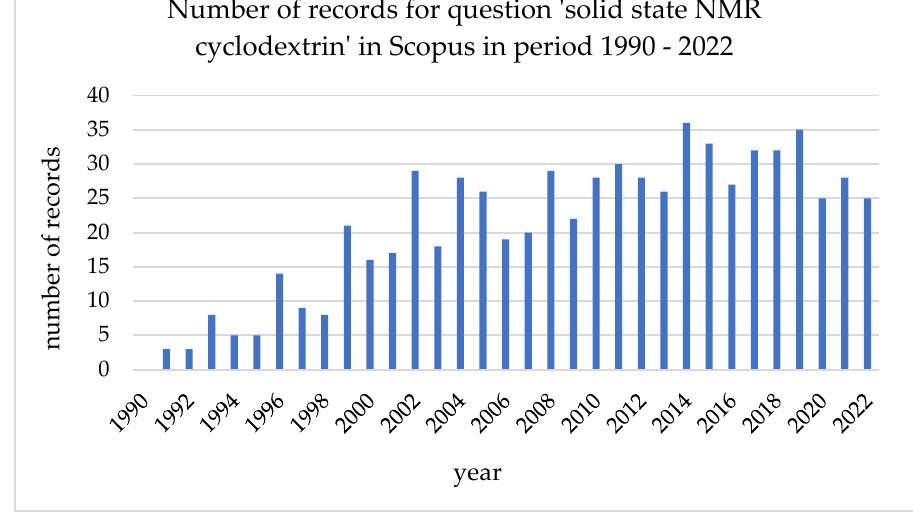
Figure 1. Number of records for query ‘solid ‐ state NMR cyclodextrin’ in Scopus in period 1990 – 2022.